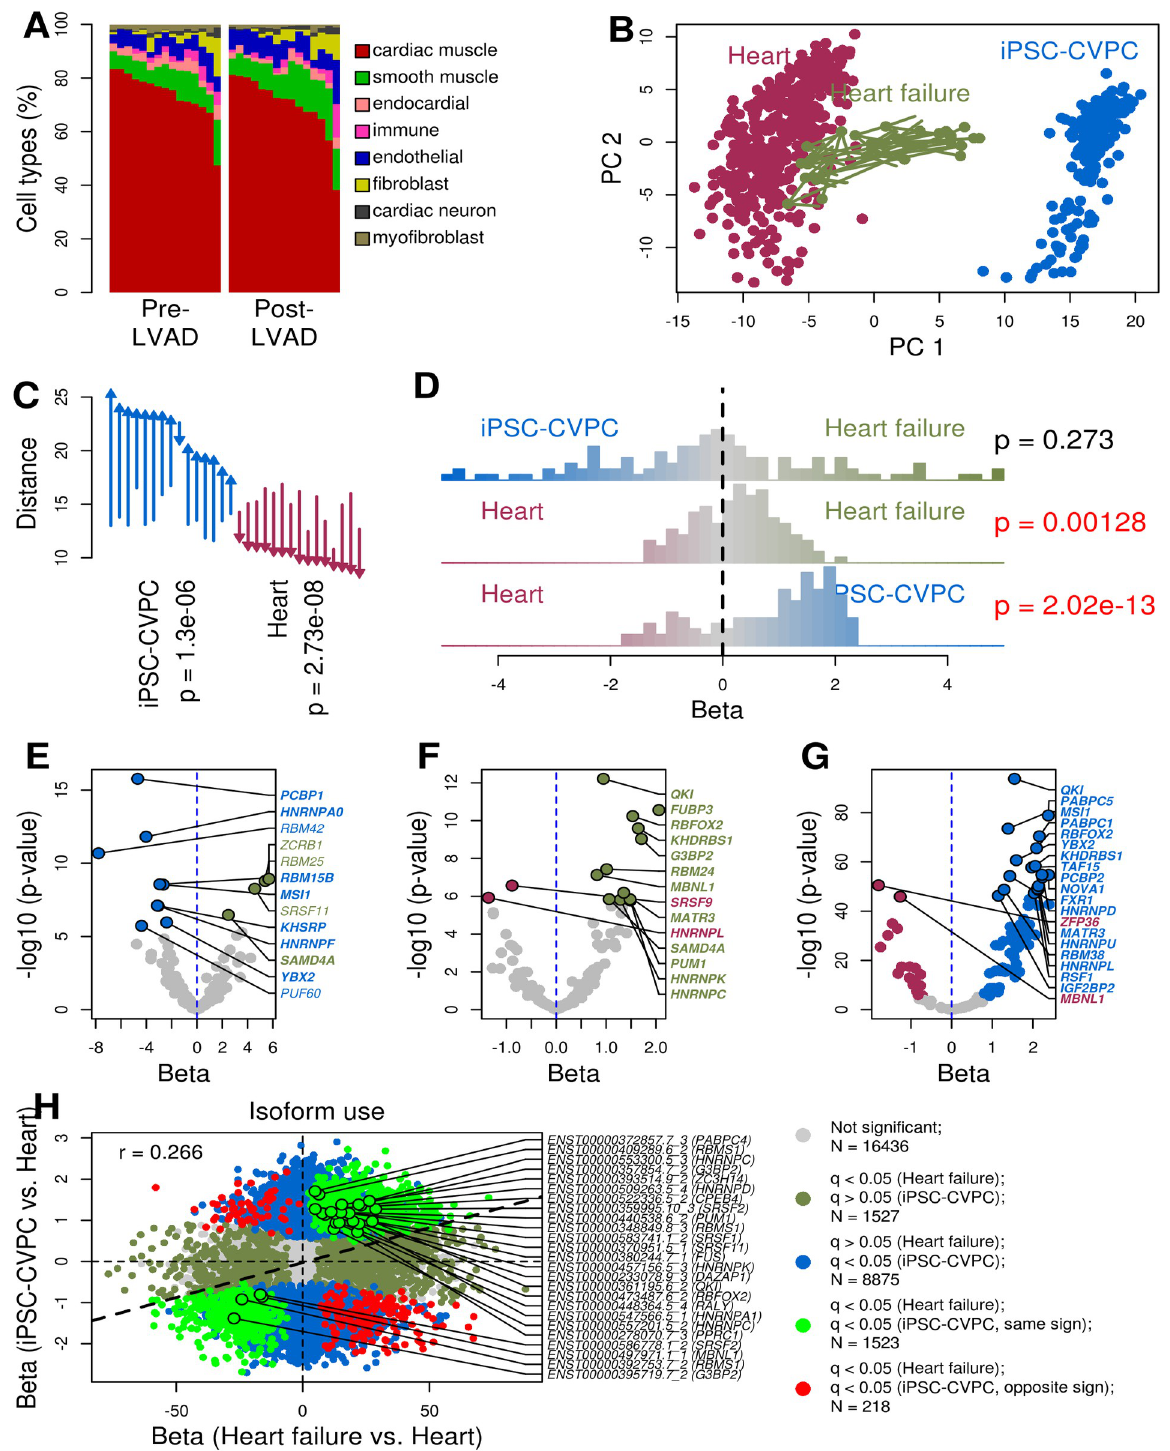
Fig 6. Reactivation of fetal-specific RBPs and isoforms in heart failure. (A) Barplot showing the cell type proportions in the 15 heart failure samples pre-LVAD (left) and post-LVAD (right). (B) Scatterplot showing the top two principal components (PC1: 46.1% variance explained; PC2: 20.5% variance explained) calculated on the expression of 122 RBPs in the integrated analysis of iPSC-CVPC, adult heart and heart failure samples. Arrows show the transcriptome changes from pre- to post-LVAD for all heart failure samples. (C) Differences in the average distance between iPSC-CVPC, adult heart and each of the 15 pairs of pre- and post-LVAD heart failure samples calculated on the expression of 122 RBPs